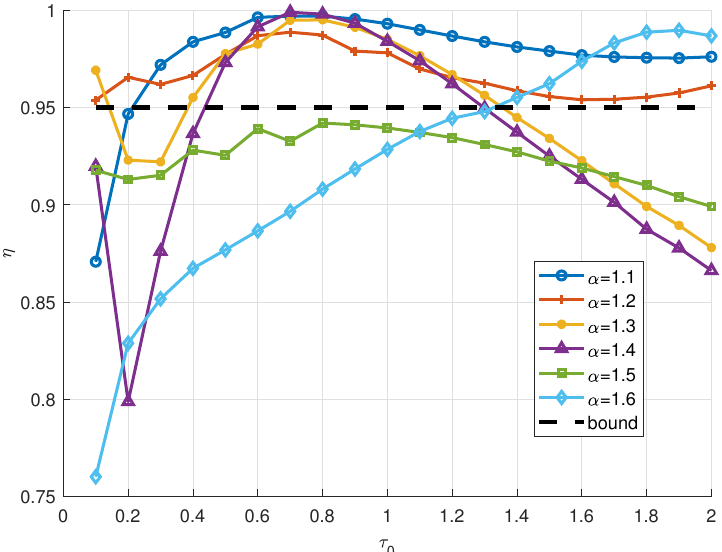
Figure 8. Index η for FOPI controllers with M t